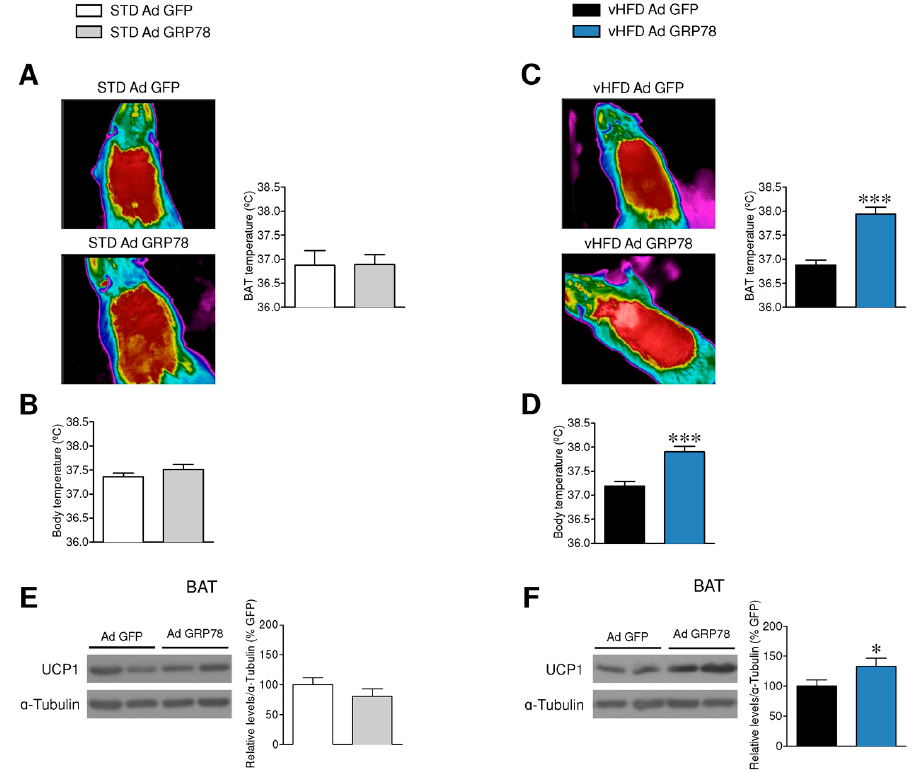
Figure 2. Effect of GRP78 overexpression in the VMH of vHFD rats on brown adipose tissue (BAT) thermogenesis. ( A , C ) Representative infrared thermal images (left panel) and temperature of the BAT area (right panels; n = 9–10 animals per group), ( B , D ) rectal temperature ( n = 8–9 animals per group) and ( E , F ) representative Western blot autoradiographic images and corresponding BAT protein levels of UCP1 ( n = 7 animals per group) of STD or vHFD rats stereotaxically treated with GFP or GRP78 adenoviruses into the VMH. Statistical significance was determined by t -Student test. Error bars represent the SEM. * p < 0.05, and *** p < 0.001 vs. (STD or vHFD) Ad GFP. For the Western blot analysis, representative images for all proteins are shown; in the case of the loading controls a representative gel is displayed, although UCP1 protein was corrected by its own internal control ( α -tubulin). In the gel images, all the bands for each picture come always from the same gel, but they may be spliced for clarity.